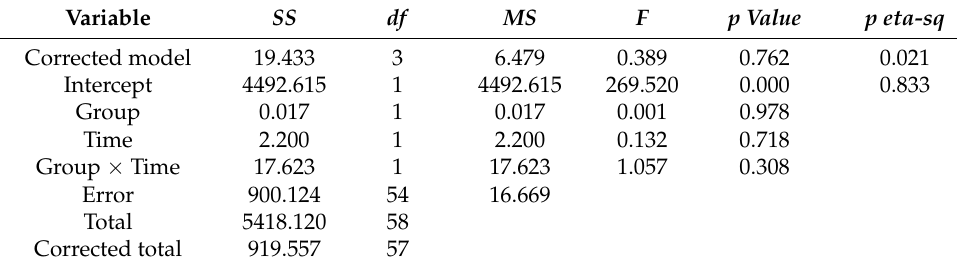
Table 4. Results of two-way ANOVA analysis of